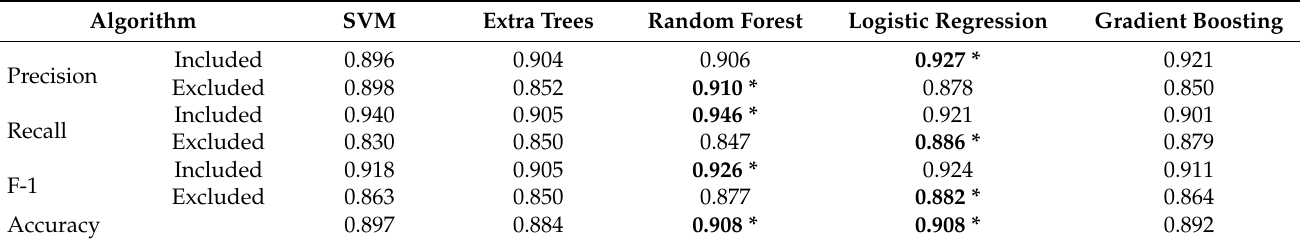
Table 1. Comparison of ML algorithms for tweet classification, implemented using the scikit- learn package.